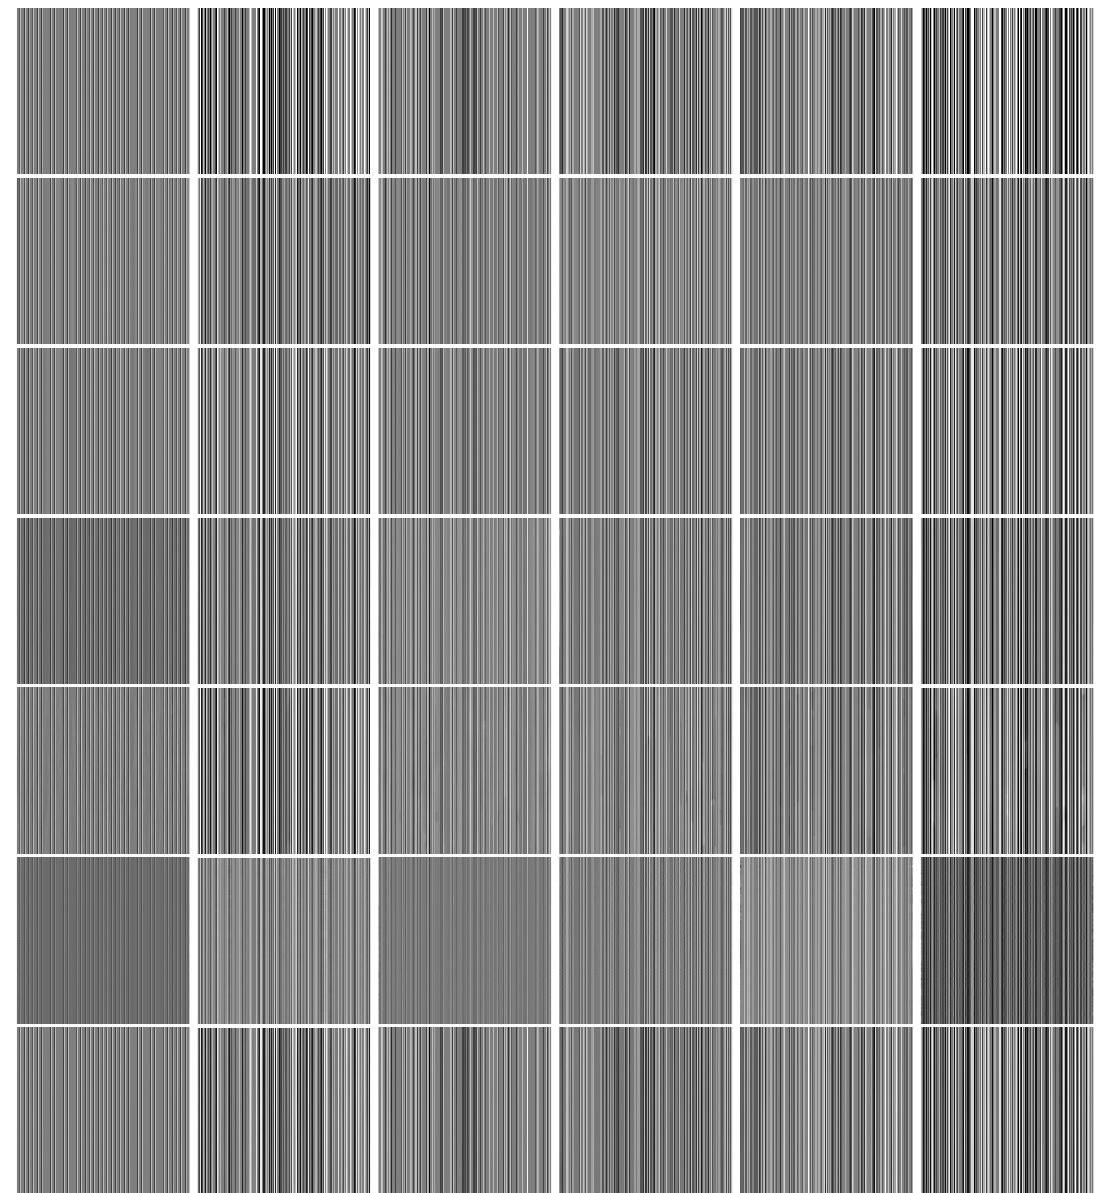
Figure 5. The stripes s of different simulated images in Figure 3. From top to bottom: the added stripes on the underlying image, the extracted stripe components of WFAF, SLD, UTV, GSLV, LRSID, and Ours. Note that the levels of stripes are same as Figure